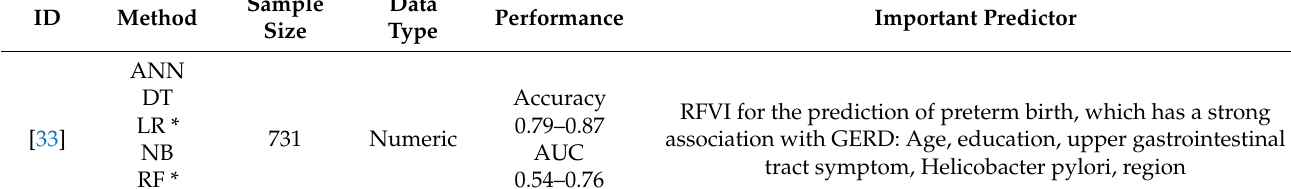
Table 1. Summary of